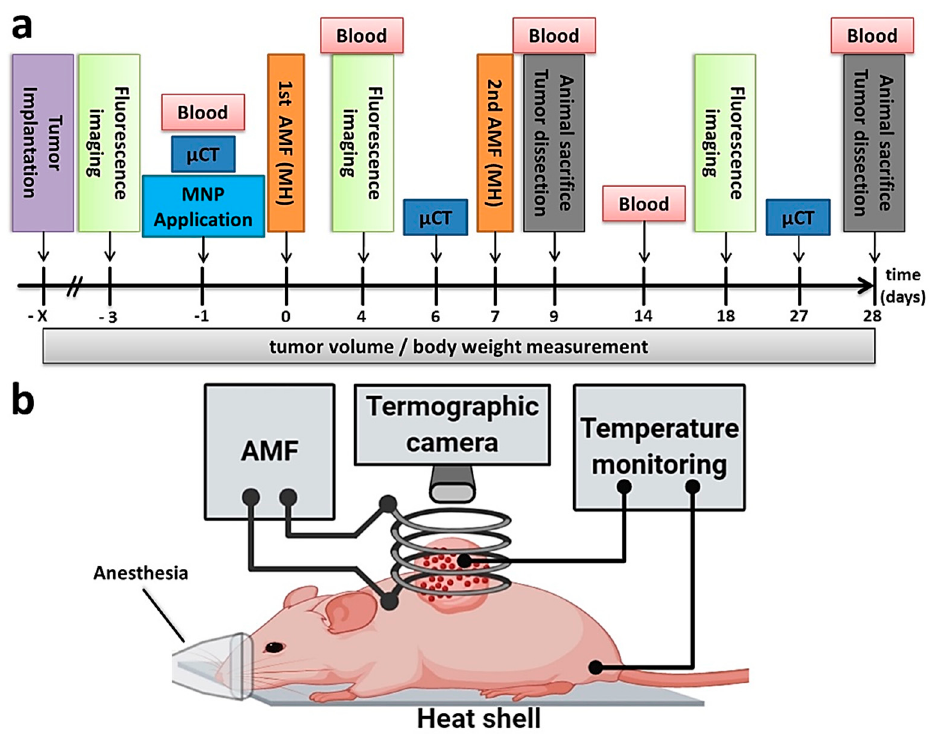
Figure 6. Procedure for in vivo experiments and experimental setup for magnetic hyperthermia. ( a ) Schematic illustration of the in vivo experiments conducted. ( b ) Magnetic hyperthermia was performed by exposure of intratumorally injected MNPs (red dots) (0.25 mg Fe/100 mm 3 tumor and 0.22 to 0.55 mg 5 FU/kg body weight) to AMF ( H = 15.4 kA/m, f = 410 kHz). AMF: alternating magnetic field; MH: magnetic hyperthermia; µCT: micro computed tomography; MNP: magnetic nanoparticle. Figure 6b is created with BioRender.com.